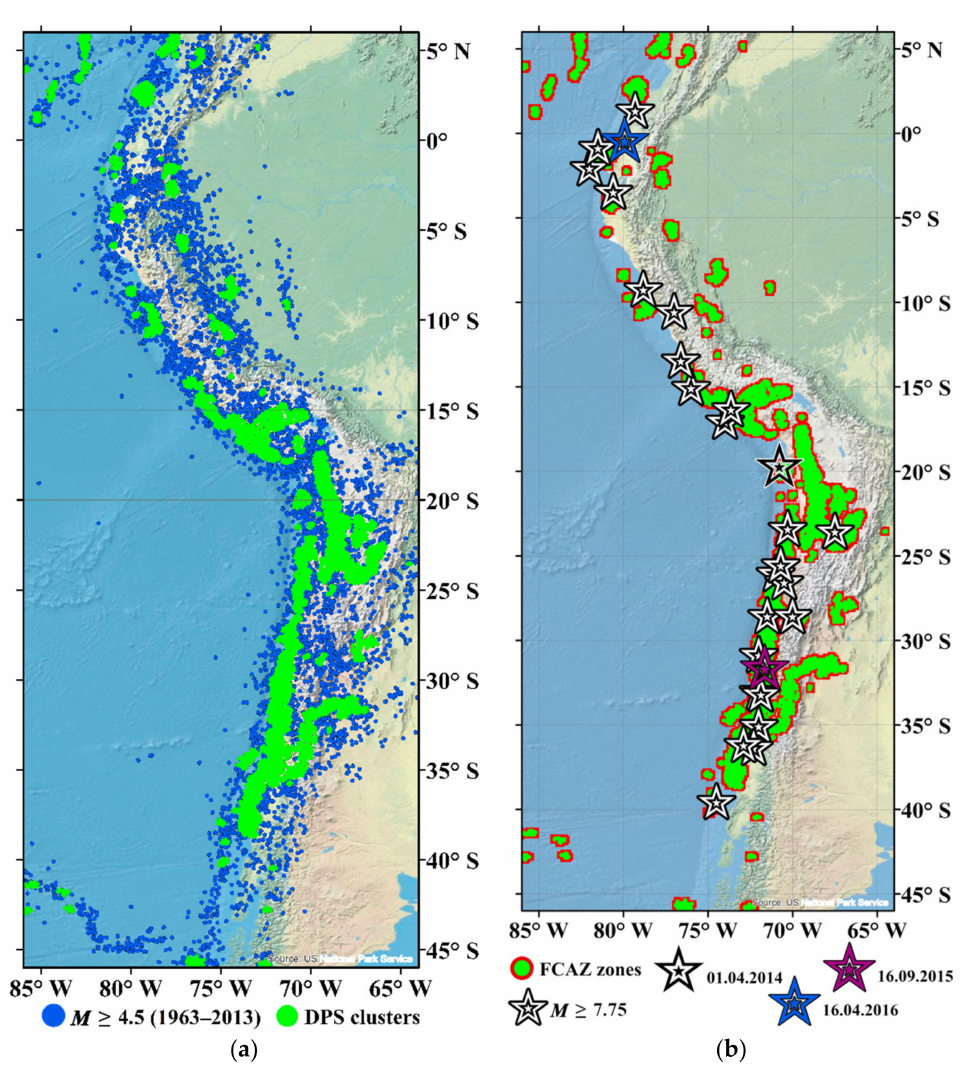
Figure 7. Mountain belt of the Andes: ( a ) FCAZ recognition objects—the epicenters of earthquakes with M ≥ 4.5 and recognized DPS clusters; ( b ) FCAZ zones prone to earthquakes with M ≥ 7.75 and the epicenters of earthquakes with M ≥